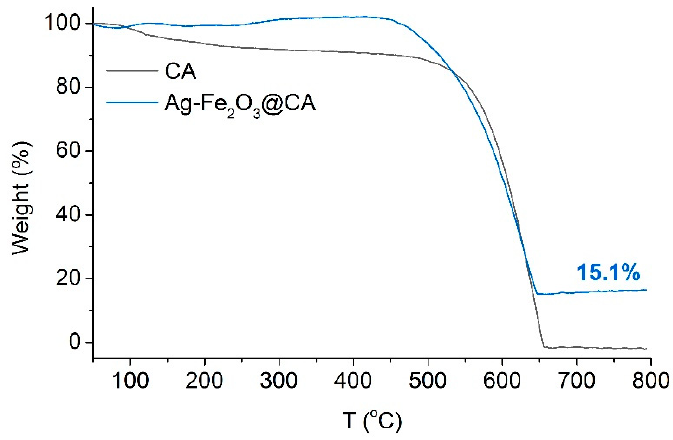
Figure 8. Thermal gravimetric curve of CA and Ag-Fe 2 O 3 @CA.